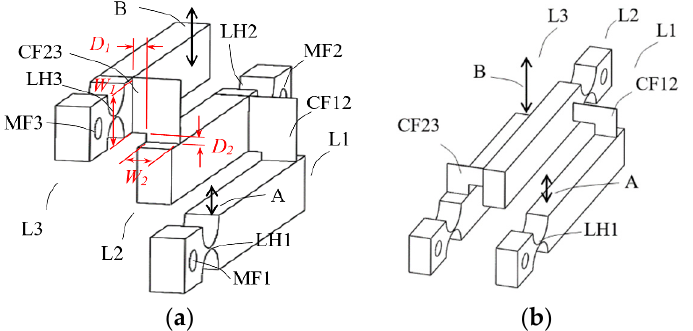
Figure 4. Conceptual design B, assembled structure of multi-planar layout with monolithic hinges, but “L-shape” flat spring couplers between levers; ( a ) coupler CF23 is “pull” type; ( b ) CF23 is “push” type.